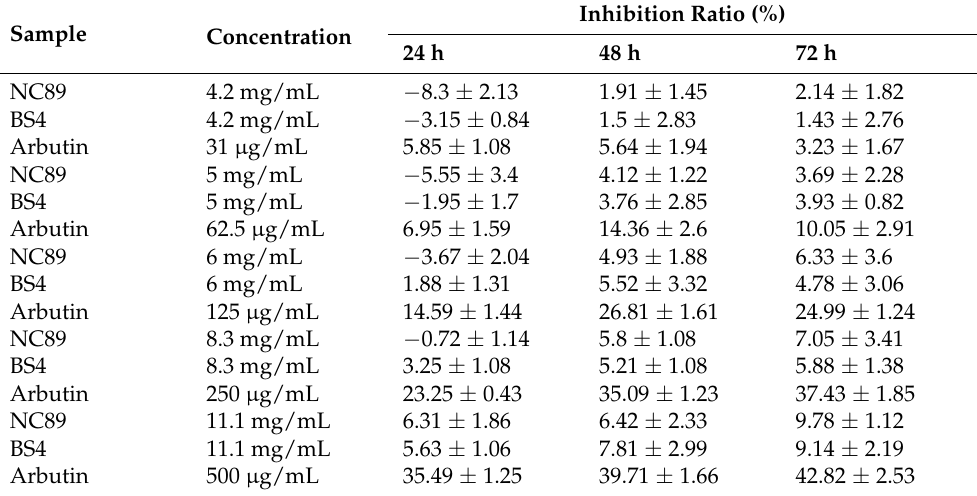
Table 6. Inhibitory effect of tobacco seed oil on melanin production in B16 cells.